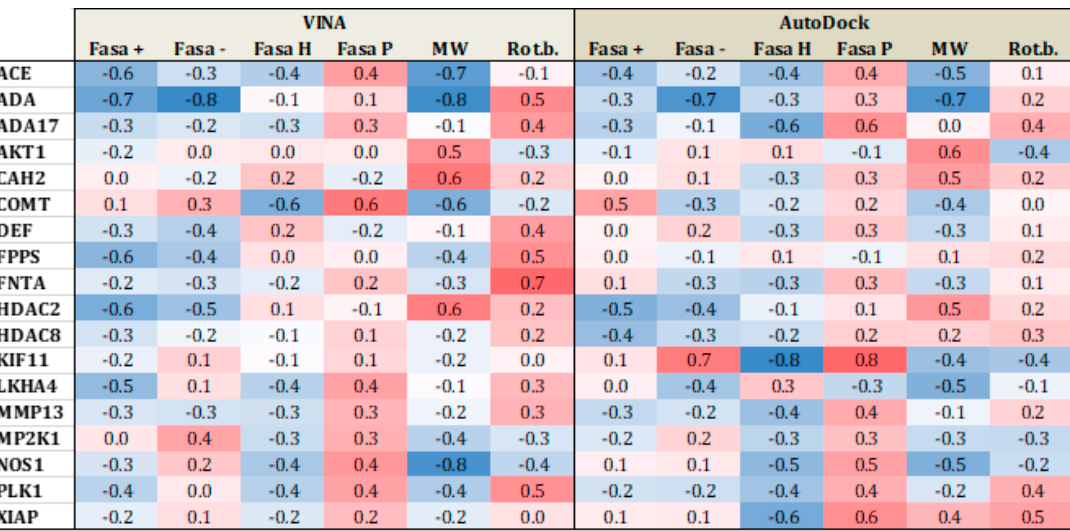
Figure 6. Heat map correlation for metalloenzymes between Vina and AutoDock scores and ligand